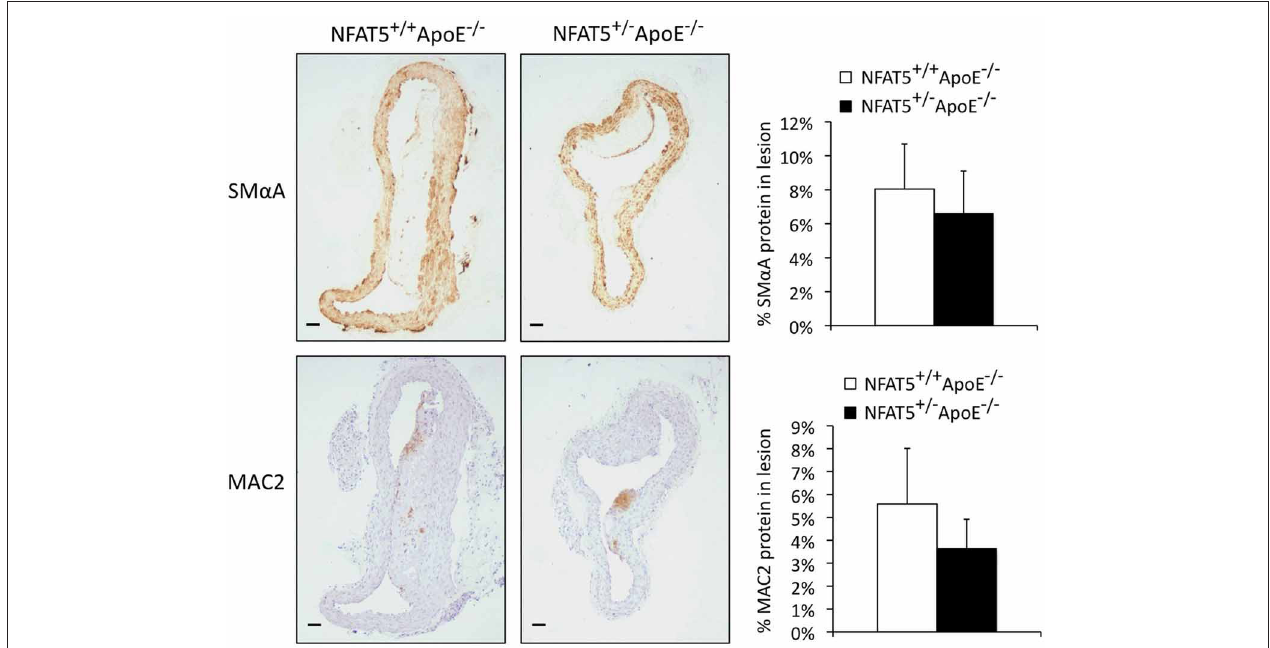
aortic arch lesions. SM α A and MAC2 are markers for smooth muscle cells and macrophages, respectively ( n = 7 NFAT5 + / + ApoE − / − mice and 11 NFAT5 + / − ApoE − / − mice, bar = 0.6 μ m).